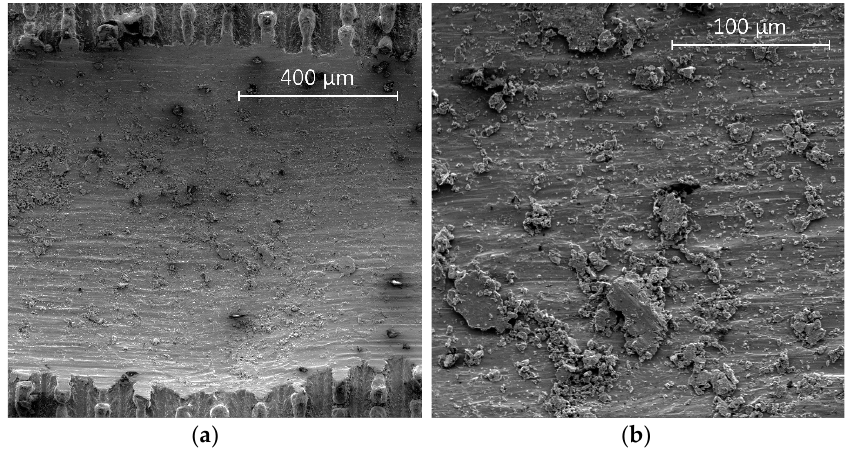
Figure 12. SEM of the wear track of the 50 Hz and 100 mm s −1 treated sample; ( a )200×, ( b )750×.